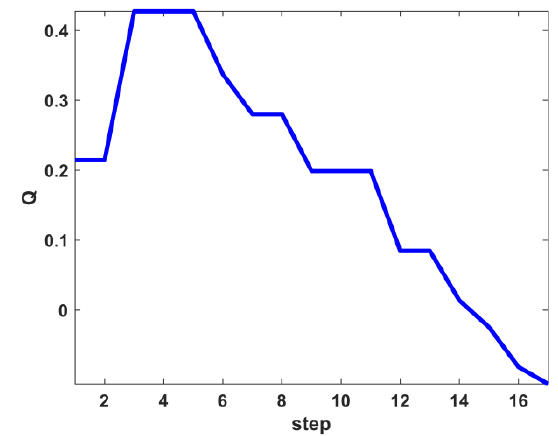
Figure 4. Modularity 𝑄 according to step number using the Girvan-Newman method. At first, calculate the Newman modularity 𝑄 and 𝑐 𝑘between for all edges of the initial network. Subsequently, remove the edge having largest 𝑐 𝑘between and the procedure is iterated. If 𝑄 reaches the maximum value, then the network becomes the optimal community structure. In this example, the optimal community was divided in three steps.